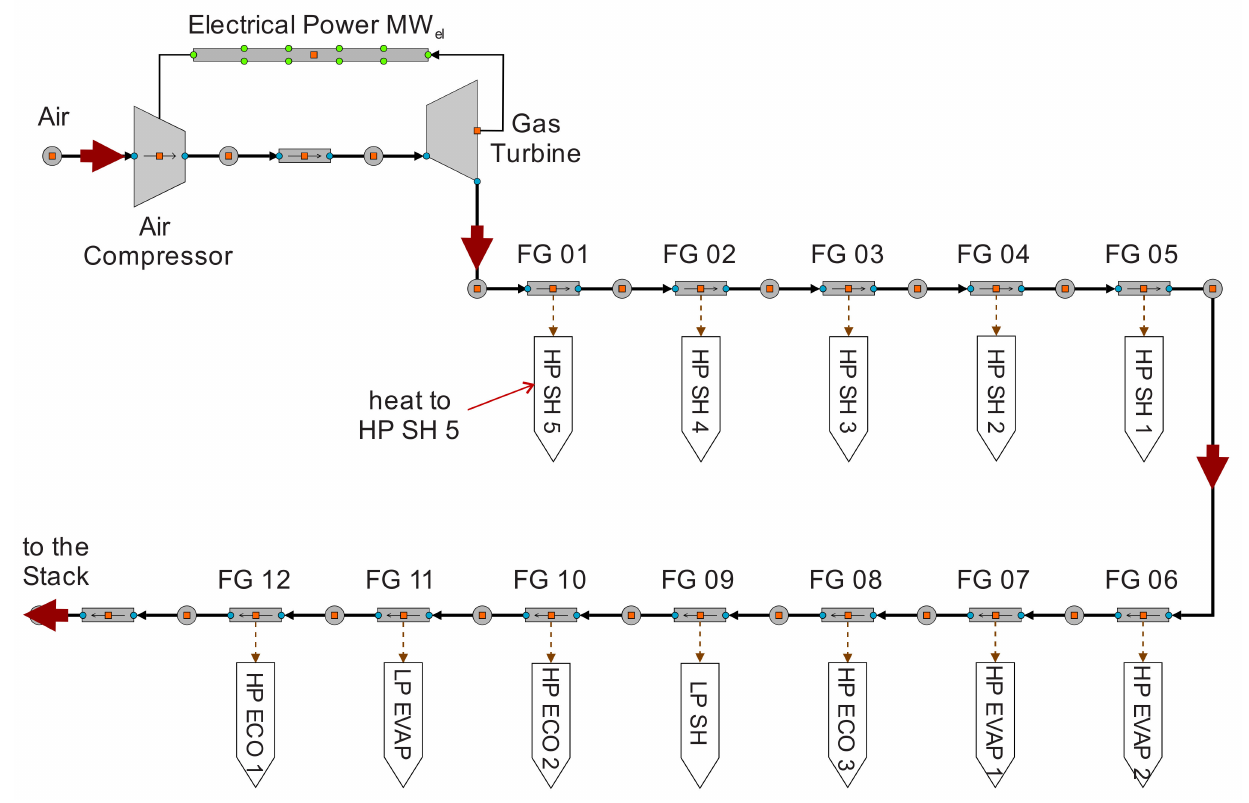
Figure 2. Schematic of the gas turbine net in